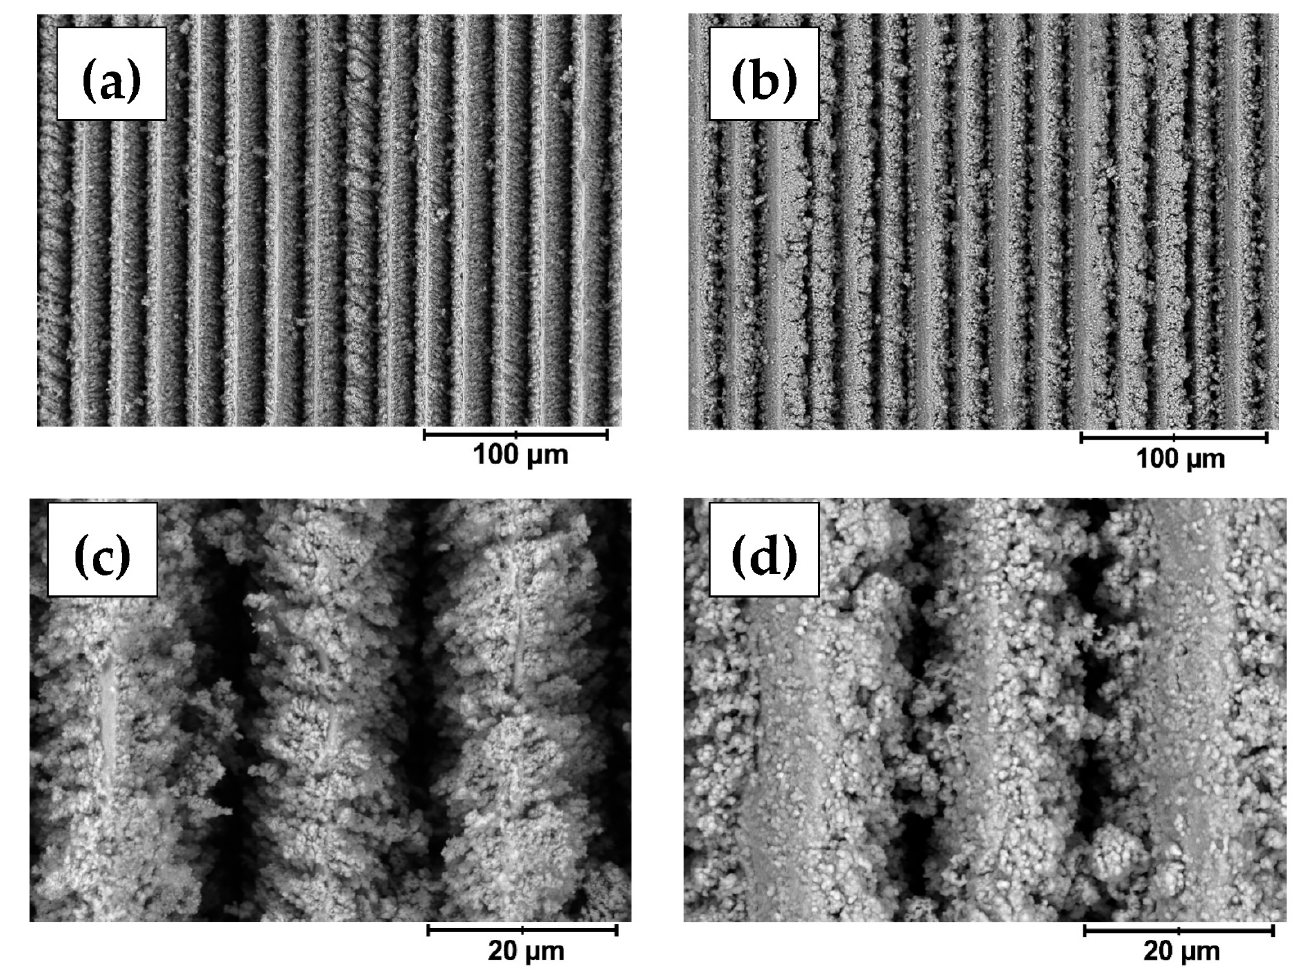
Figure 2. The SEM images of the ( a , c ) fs-Cu, and ( b , d ) fs-Cu/MoS 2